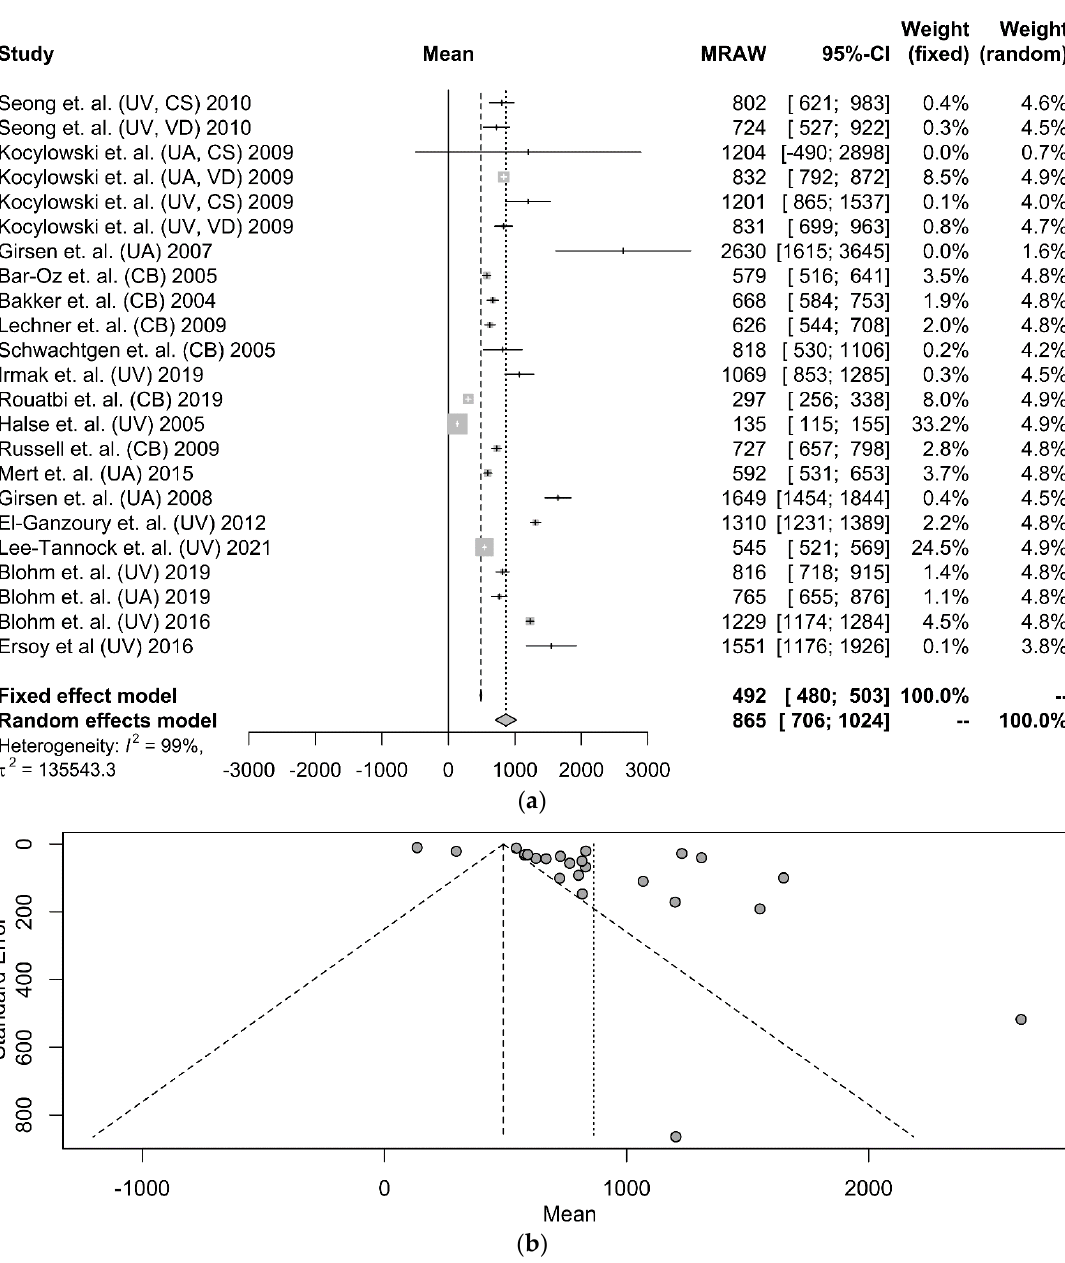
Figure 2. ( a ) A forest plot that presents the results of the meta-analysis: umbilical cord NT-proBNP values of term infants using the random model and the fixed model, respectively. The first column refers to the first author of the study, the year of publication, and the sampling vessel. The second column represents the mean value and the standard deviation graph. The next 3 columns show the mean value and the 95% confidence interval. The remaining 2 columns present the fixed model and random model weights [16,18,20,21,23,24,26,27,29,31,33–40]. ( b ) The corresponding funnel plot is presented at the bottom. (UV: umbilical vein, UA: umbilical artery, CB: cord blood, CS: cesarean section, VD: vaginal delivery).